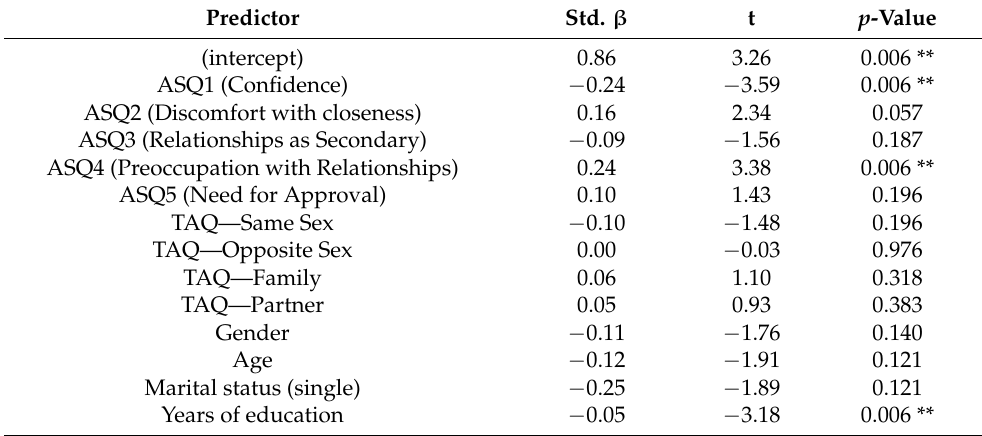
Table 2. Results of the multiple linear regression model. Df = 226. ** = significant for p < 0.01. All p -values have been adjusted using Benjamini–Hochberg’s correction for multiple comparisons. Predictor Std. β t p -Value (intercept) 0.86 3.26 0.006 ** ASQ1 (Confidence) − 0.24 − 3.59 0.006 ** ASQ2 (Discomfort with closeness) 0.16 2.34 0.057 ASQ3 (Relationships as Secondary) − 0.09 − 1.56 0.187 ASQ4 (Preoccupation with Relationships) 0.24 3.38 0.006 ** ASQ5 (Need for Approval) 0.10 1.43 0.196 TAQ—Same Sex − 0.10 − 1.48 0.196 TAQ—Opposite Sex 0.00 − 0.03 0.976 TAQ—Family 0.06 1.10 0.318 TAQ—Partner 0.05 0.93 0.383 Gender − 0.11 − 1.76 0.140 Age − 0.12 − 1.91 0.121 Marital status (single) − 0.25 − 1.89 0.121 Years of education − 0.05 − 3.18 0.006